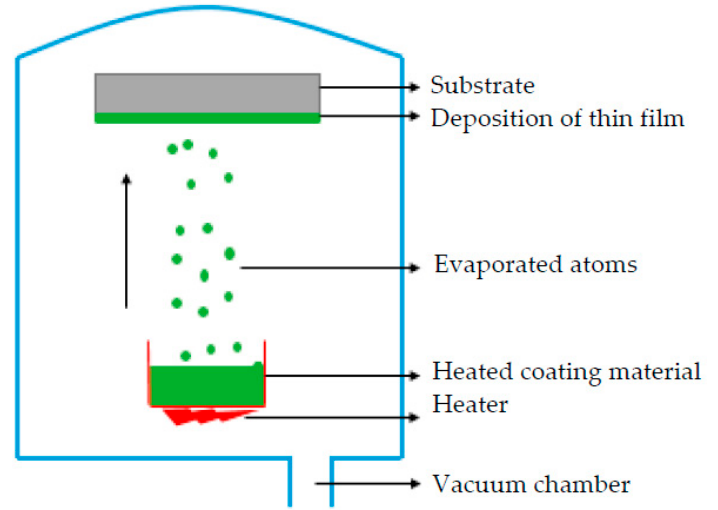
Figure 4. Schematic process of coating deposition by using PVD